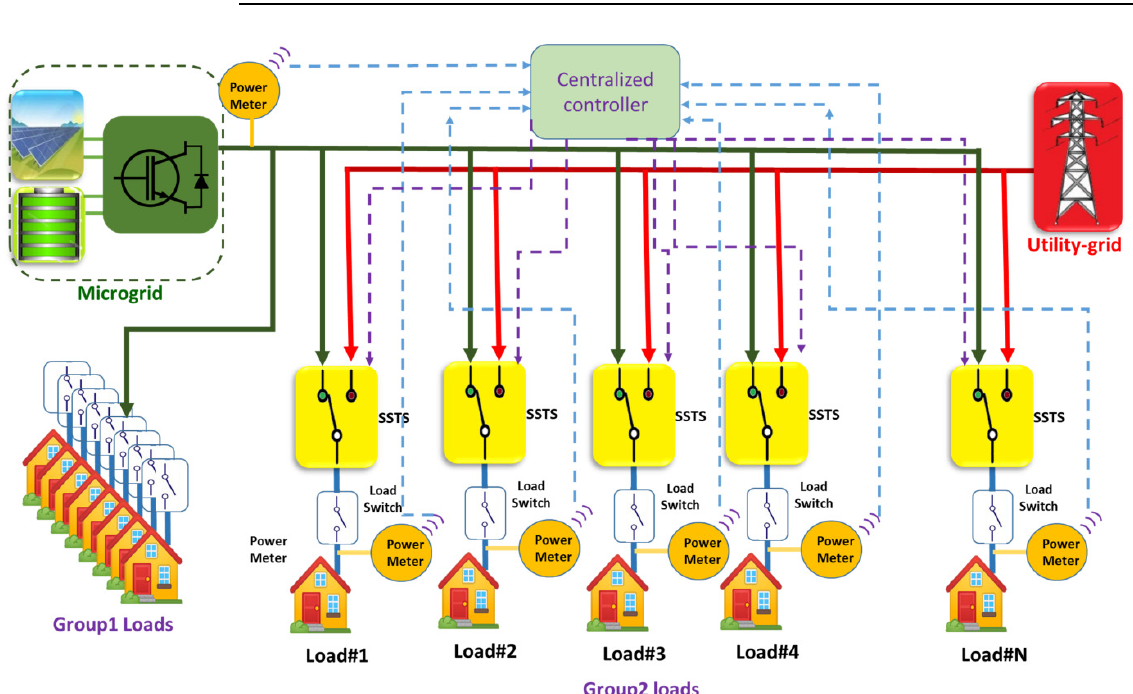
Figure 12. Detailed architecture of microgrid operating in partially grid-connected mode. The solid lines denote to power flow and dashed lines denote to communication flow. Algorithm 3 Pseudocode of loads selecting and transferring to the utility-grid